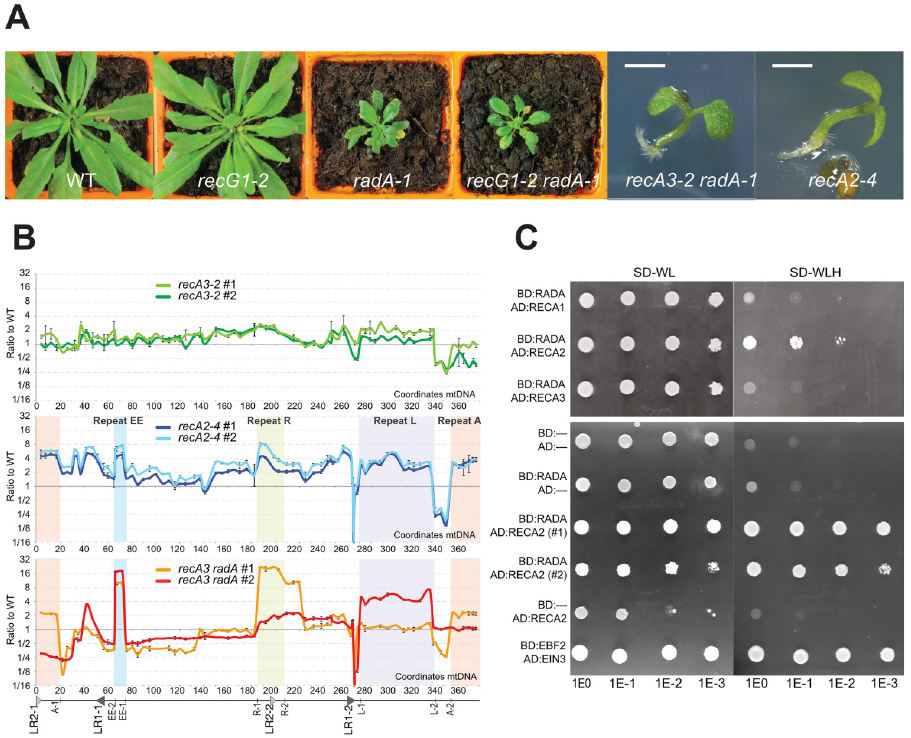
Fig 7. Synergistic effect of radA with recA3 but not with recG1 is consistent with a role in the RECA2-dependent pathway. ( A ) Crosses of recG1-2 and radA-1 (pollen donor) showed that double homozygote recG1 radA plants are as affected in development as simple homozygote radA plants. Contrarily, double homozygote recA3 radA do not grow roots and are lethal at the seedling stage, a phenotype similar to the one of recA2 . The scale bar is 1 mm. ( B ) qPCR scanning of relative copy numbers of the different mtDNA regions, as described in Fig 6, in pools of recA3 , recA2 and recA3 radA seedlings. Results were compared to those of WT seedling of same size, and are represented in log2 scale. ( C ) RADA interacts with RECA2, but not with RECA1 or with RECA3, on a yeast two-hybrid assay. Serial dilutions of cell suspensions were spotted. BD and AD are the binding and activating domains of GAL4, respectively. Replicate experiments with two independent yeast colonies co-transformed with both plasmids (#1 and #2) confirmed this result, and controls with empty vectors showed that there was no autoactivation by either BD:RADA or AD:RECA2 (lower panel). The interaction between the F-box protein EBF2 and EIN3 was used as positive